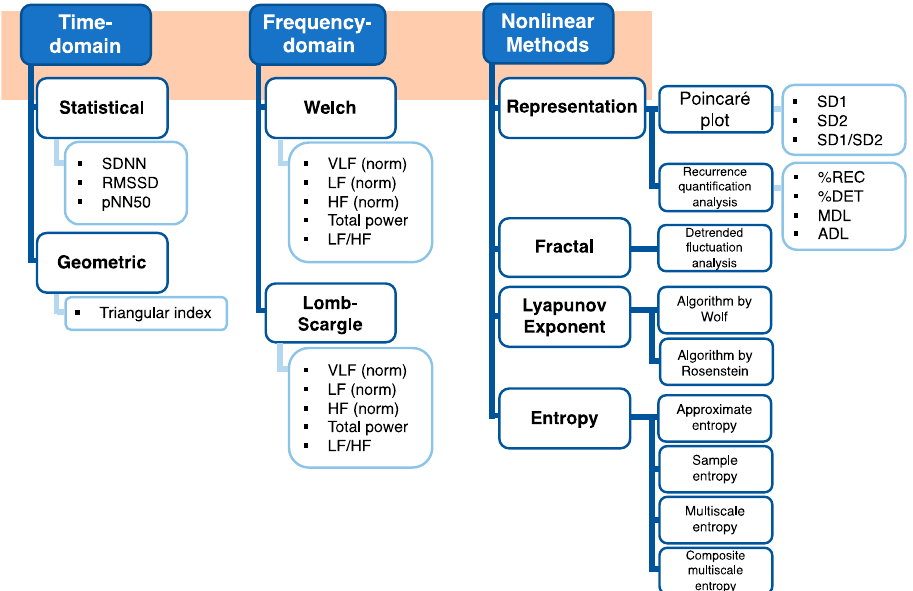
Figure 1. Approaches, methods, and outputted measures used to calculate HRV in the study.